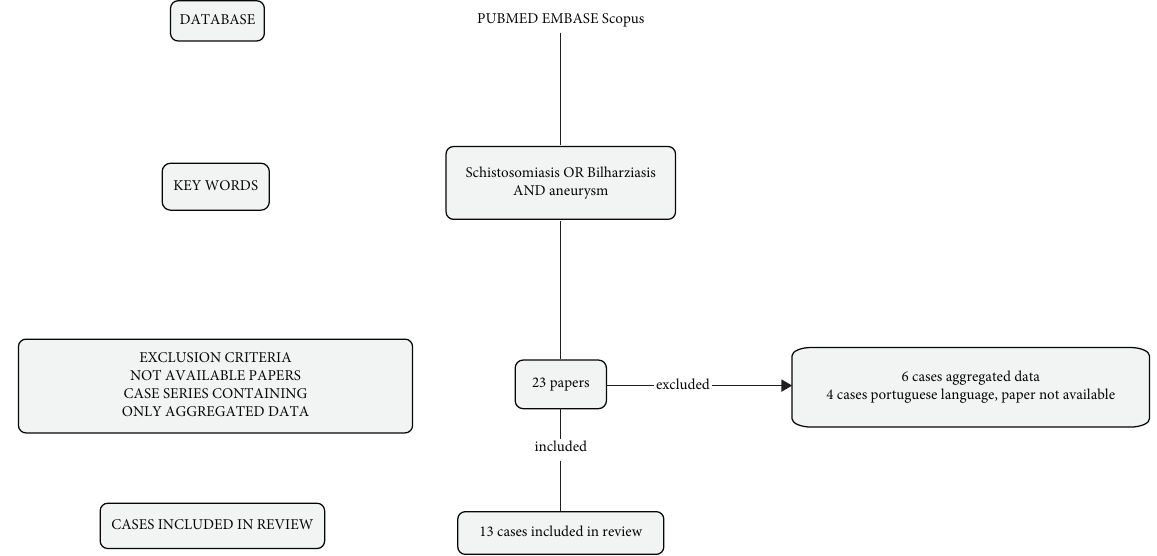
Figure 1: Review process